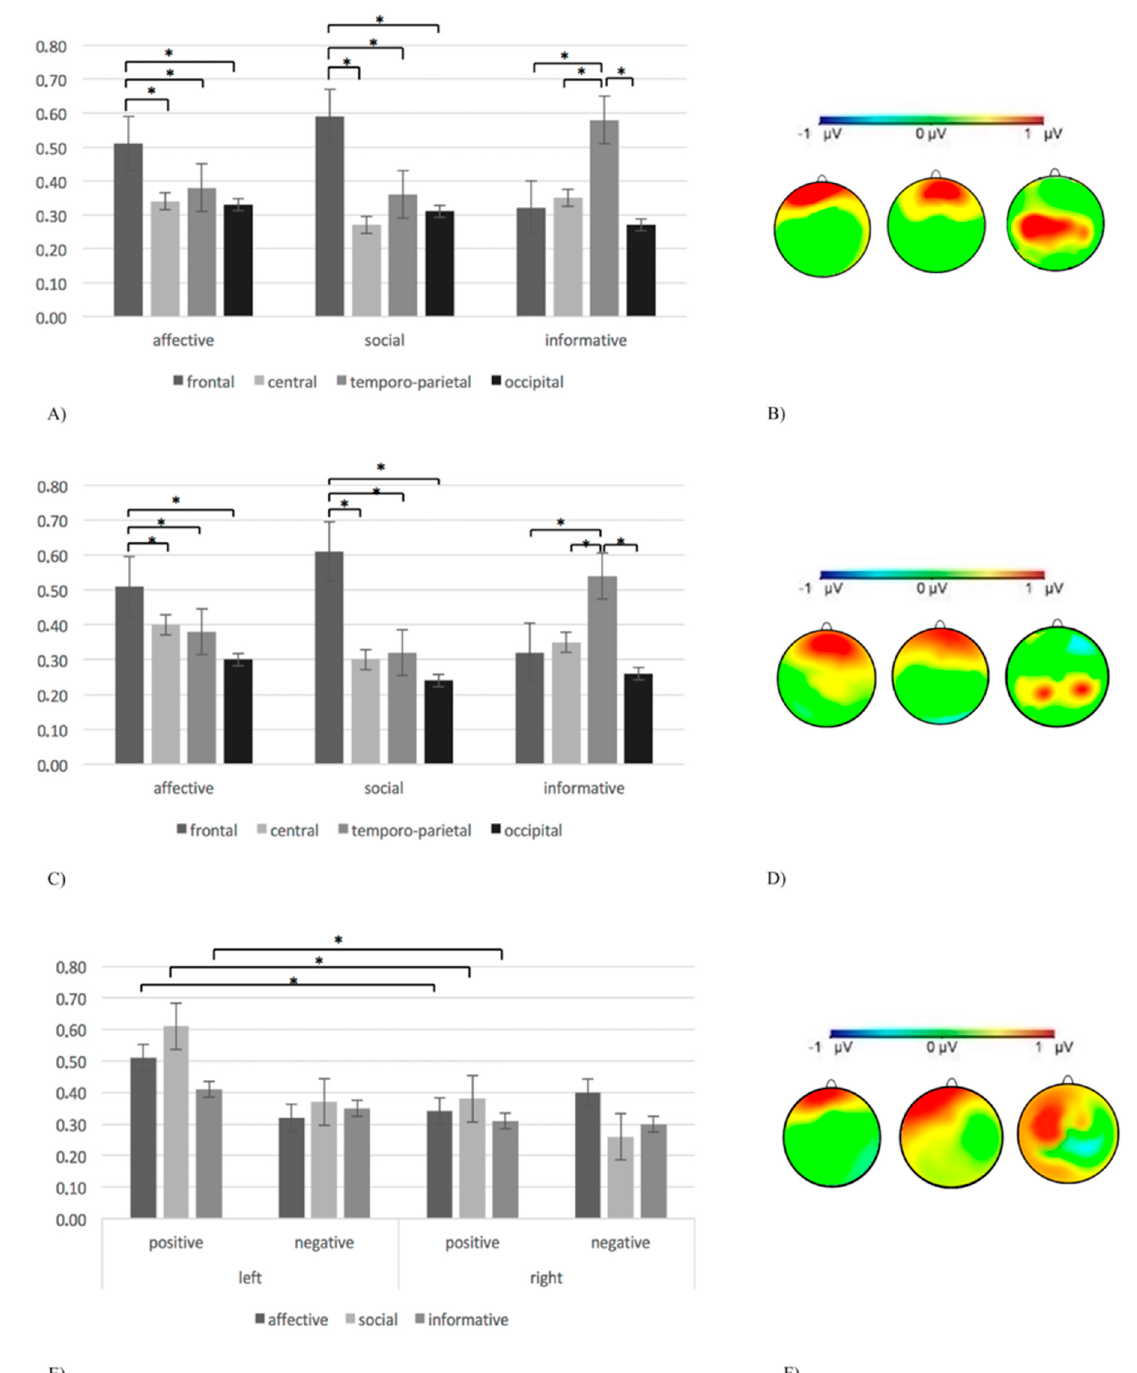
Figure 2. ( A ) A bar chart of alpha intra-brain connectivity for the three types of gestures (affective, social, and informative) in the frontal, central, temporo-parietal, and occipital areas. The bar chart shows the increase in frontal alpha intra-brain connectivity for affective and social gestures, and the increase in posterior alpha intra-brain connectivity for informative ones. Bars indicate ± 1 SE. Statistically significant pairwise comparisons ( p < 0.05) are marked by an asterisk. ( B ) Alpha intra-brain connectivity representations for affective (left side), social (middle), and informative (right side) gestures. The increase in alpha intra-brain connectivity is marked by the red area. ( C ) A bar chart of delta intra-brain connectivity for the three types of gestures (affective, social, and informative) in frontal, central, temporo-parietal, and occipital areas. The bar chart shows the increase in frontal delta intra-brain connectivity for the affective and social gestures, and the increase in posterior delta intra-brain connectivity for the informative gestures. Bars indicate ± 1 SE. Statistically significant pairwise comparisons ( p < 0.05) are marked by an asterisk. ( D ) Delta intra-brain connectivity representations for affective (left side), social (middle), and informative (right side) gestures. The increase in delta intra-brain